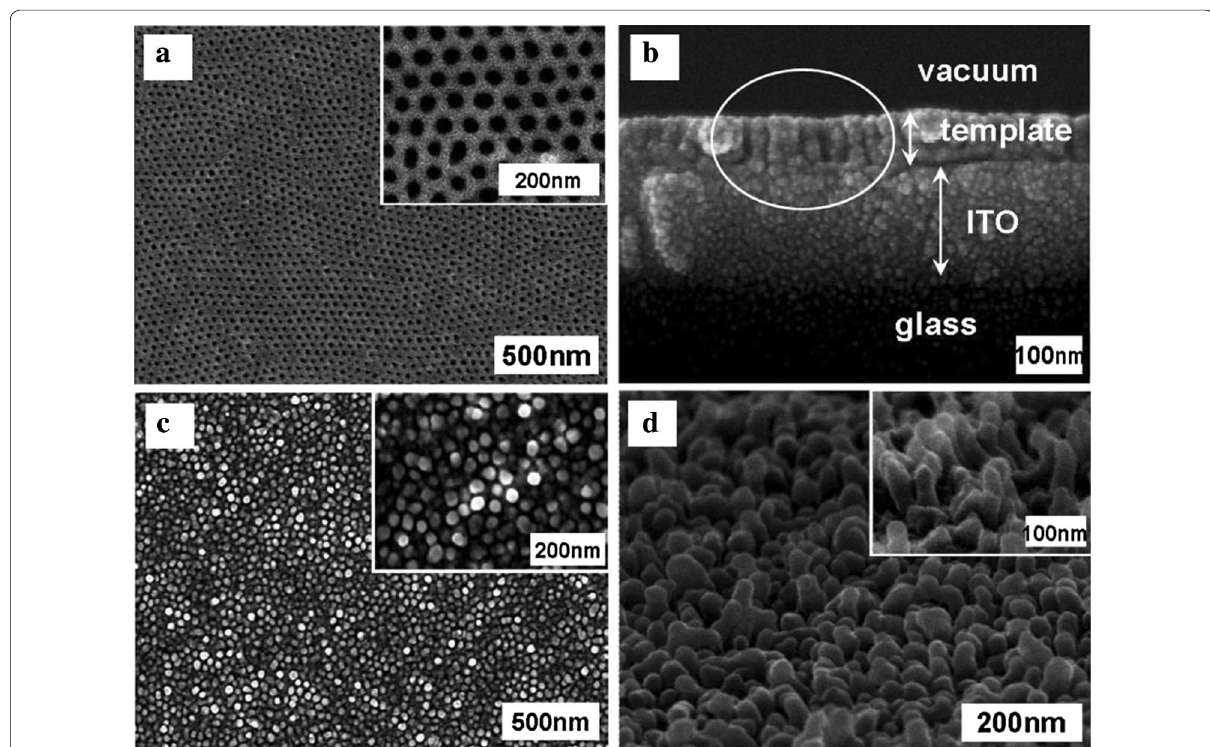
Fig. 10 FE-SEM images of nanoporous templates prepared by the block copolymer mixture film on the ITO glass and polypyrrole nanorods. a , b Top and cross-sectional images of the nanoporous template. c , d Top and cross-sectional images of polypyrrole nanorods after removing the template